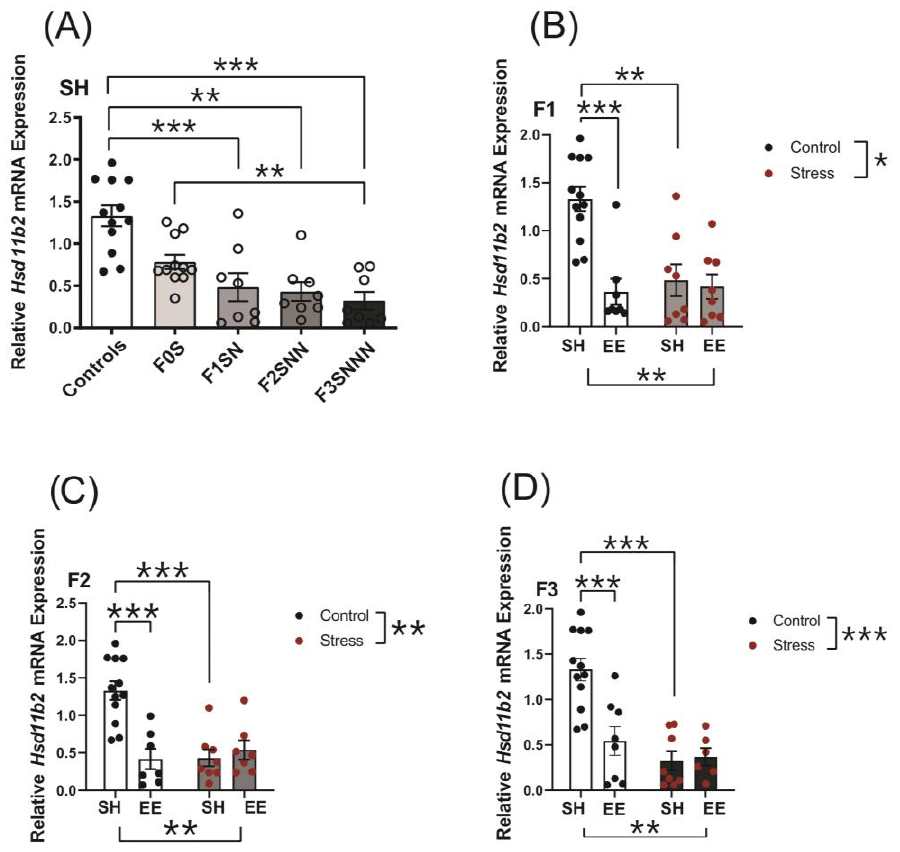
Figure 10. Uterine expression of Hsd11b2 is significantly decreased in F1–F3 stressed dams and in the animals exposed to EE housing. ( A ) Gene expression of Hsd11b2 in uteri of control and stressed dams across the F0–F3 generations. Uterine expression of Hsd11b2 in ( B ) F1, ( C ) F2, and ( D ) F3 animals exposed to different treatments and housing conditions. Asterisks indicate significance: <0.05 (*); 0.002 (**); <0.001 (***). Data are compared to F0N, mean ± SEM. Ordinary one-way ANOVA ( A )